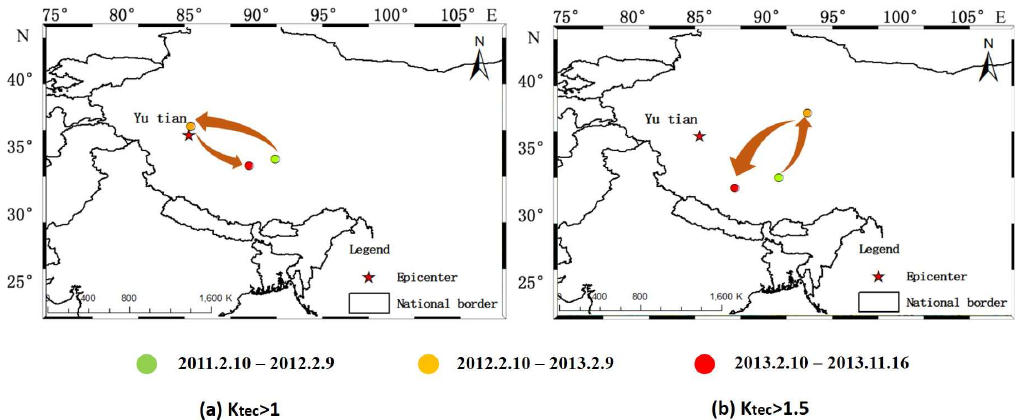
Figure 12. Movement tendencies of the TIR anomalies intensity centroid during the Yutian earthquake event with: ( a ) K tec ≥ 1.0; and ( b ) K tec ≥ 1.5.